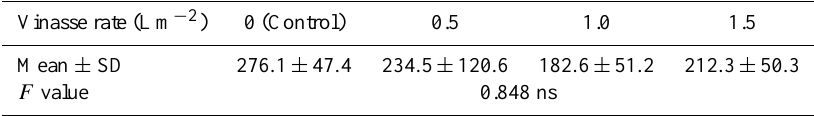
Table 4. Mean and standard deviation (Mean ± SD) of soil loss amount (g) under different vinasse treatments in the study 0.25m 2 -plots.